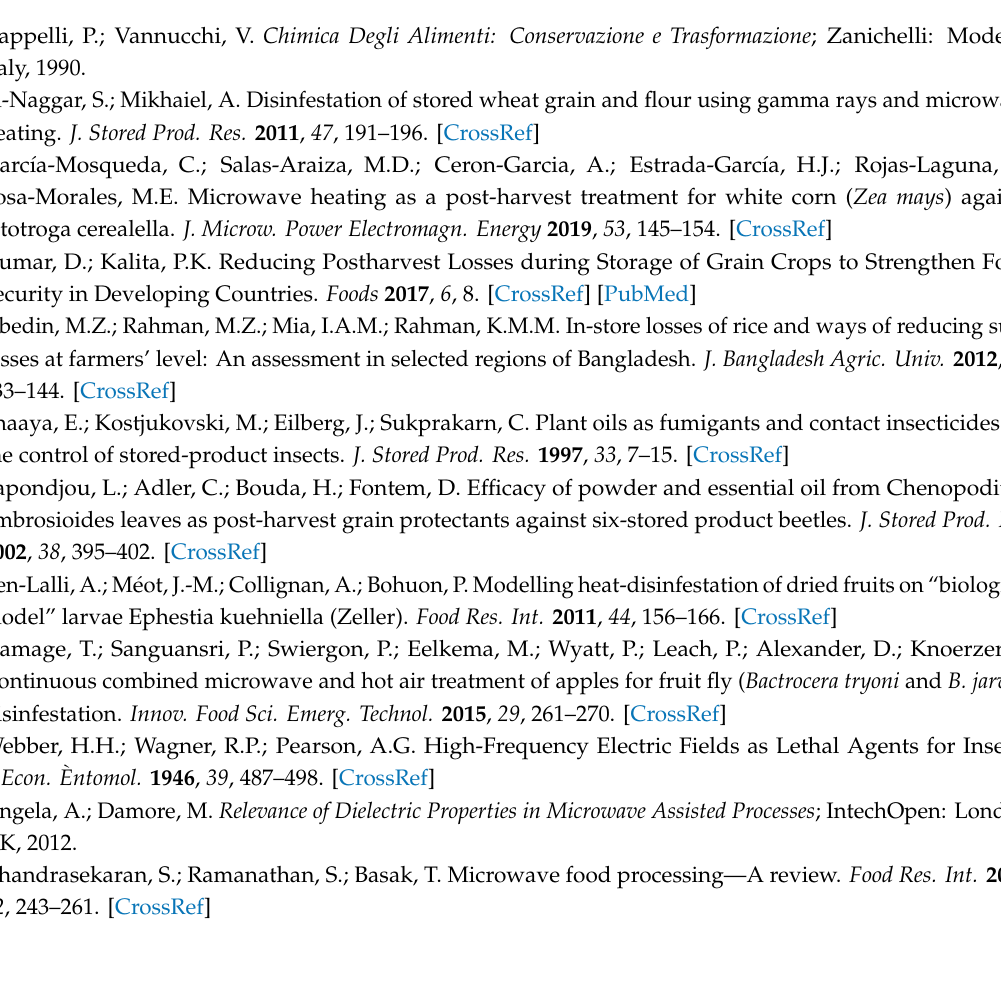
Figure S1: Permittivity, i.e. dielectric constant (Re) and loss factor (Im) for milled weak wheat (closed and open squares, respectively), durum wheat (closed and open triangles, respectively), corn (closed and open circles, respectively), and moisture contents; Figure S2: Behavior of surface temperature with time for weak wheat (squares), durum wheat (triangles), corn (circles), initial moisture contents, and both e ff ective (EM) and uncontrolled (UCM) treatment times; Figure S3: TGA curves in presence of air in A) and DSC curves in B) for UN (black), EM (dark gray), and UCM (light